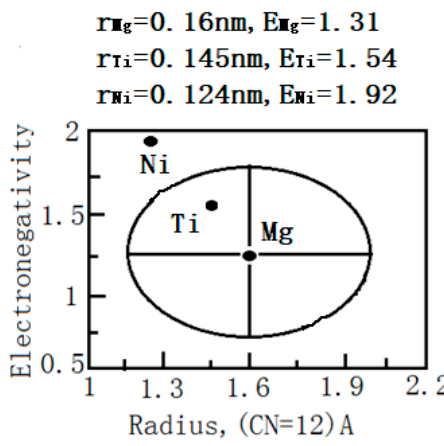
Figure 5. Position of Ti and Ni in the Darken–Gurry ellipse of Mg and electronegativity.